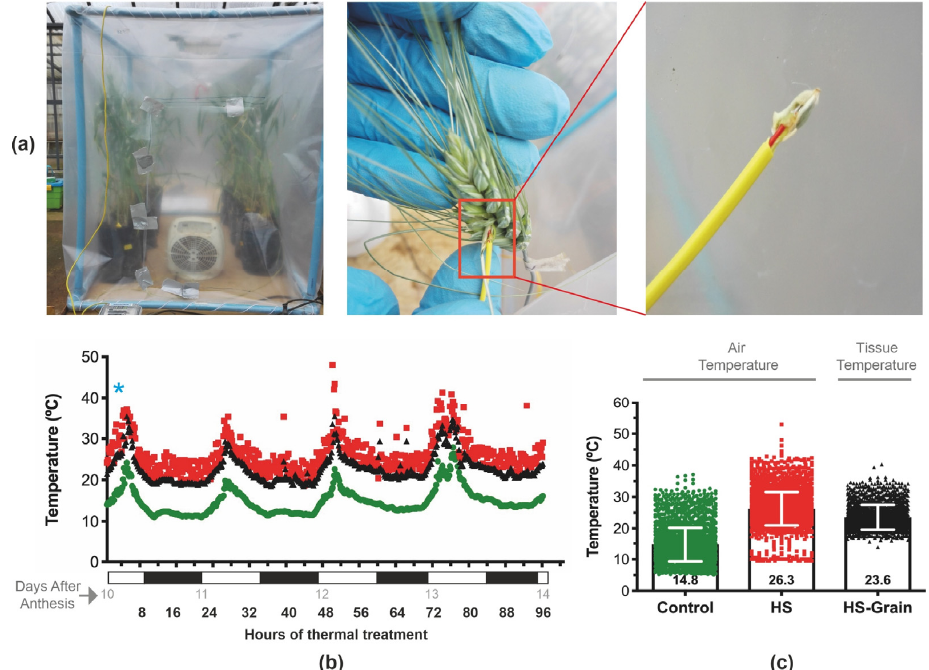
Figure 1. Heat stress chamber and temperature conditions of thermal treatments. ( a ) Wheat plants during heat treatments in polyethylene chambers (left), thermocouple in a wheat spike (middle), and a close-up of the probe inside a grain (right). ( b ) Temperature profiles from a representative experiment during 4 days of thermal treatments. Temperatures were recorded every 10 to 15 min. Control (glasshouse ambient air temperature in green dots), heat-stress (HS) treatment (air temperature inside of chambers in red squares), and tissue temperatures in grain during heat stress (black triangles). The blue asterisk shows the time when the transcriptomic analysis was performed. The alternating black and white bands on the X-axes indicate the night and day hours, respectively. The number of “Days After Anthesis” is indicated below X-axis in gray color. ( c ) Graphical display of temperature data from five independent thermal experiments. Inside each column, mean and error bar. The tissue temperatures in grain were recorded only in three independent experiments.